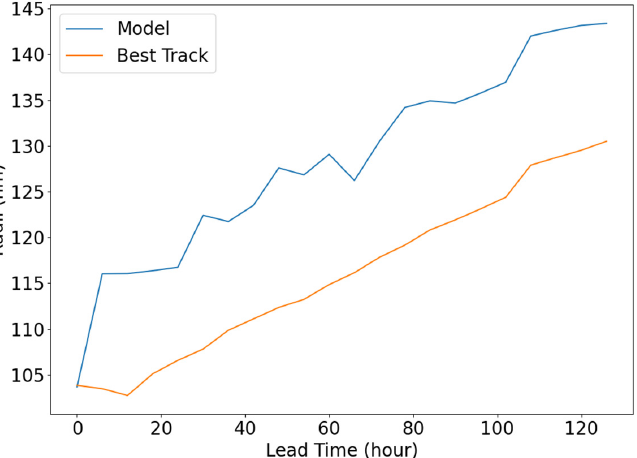
Figure 8. Hurricane Dorian (2019) 34 kt wind radii in best track (brown) and model forecast (blue) by forecast lead time.